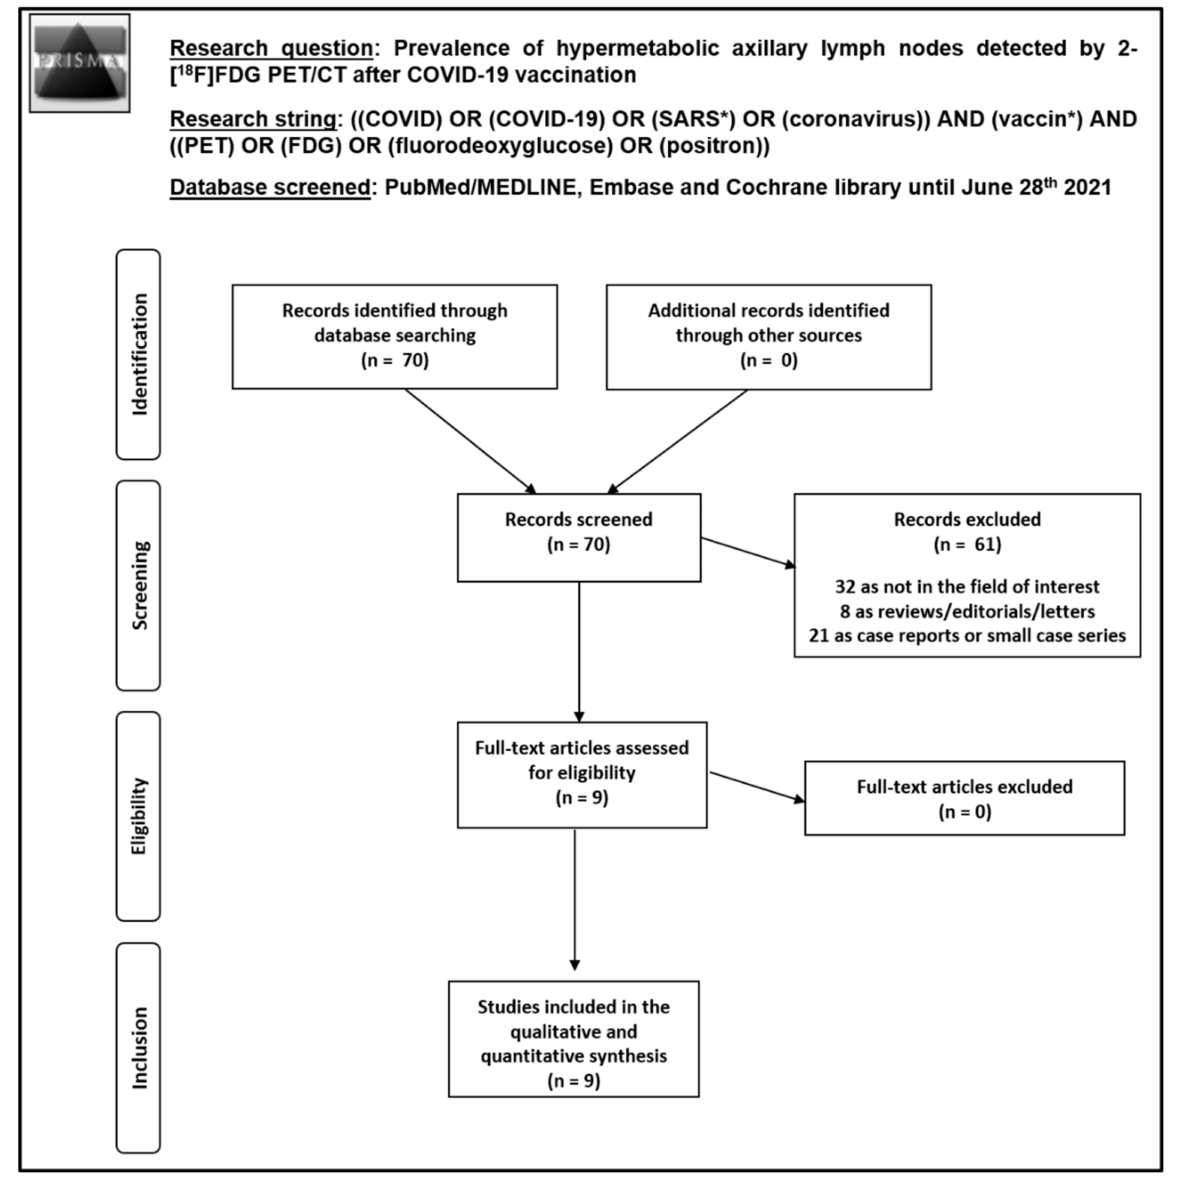
Figure 2. Process of article